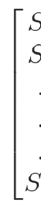
Fig. 3. Harmony memory